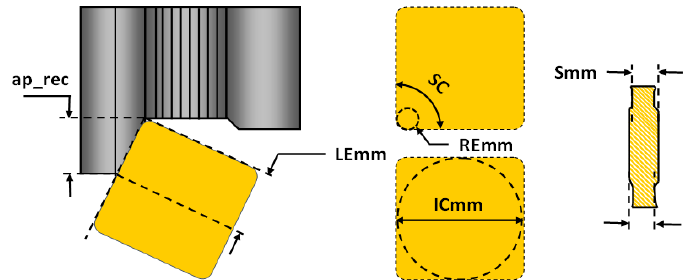
Figure 1. Tool-insert features considered in this study [25]; cutting length (LEmm); corner radius (REmm); thickness (Smm); and shape angle (SC).